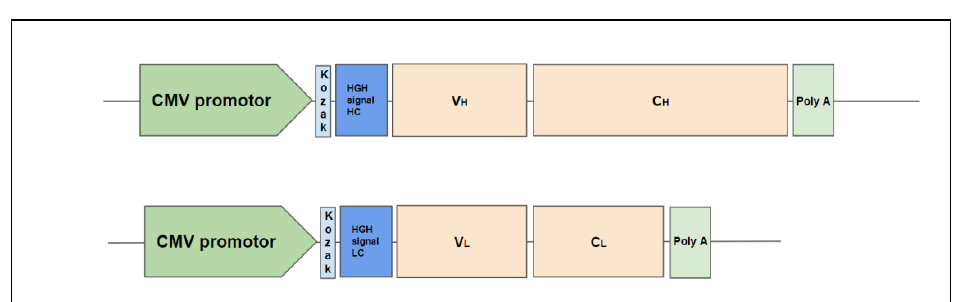
Figure A1. Schematic representation of expression cassettes encoding the heavy and light chains of antibodies: CMV, cytomegalovirus promoter; Kozak, Kozak sequence; HGH signal LC/HC, signal peptide; VH/VL, variable domain of heavy/light chain; CH/CL, constant domain of heavy/light chain; PolyA, SV40 polyadenylation signal.